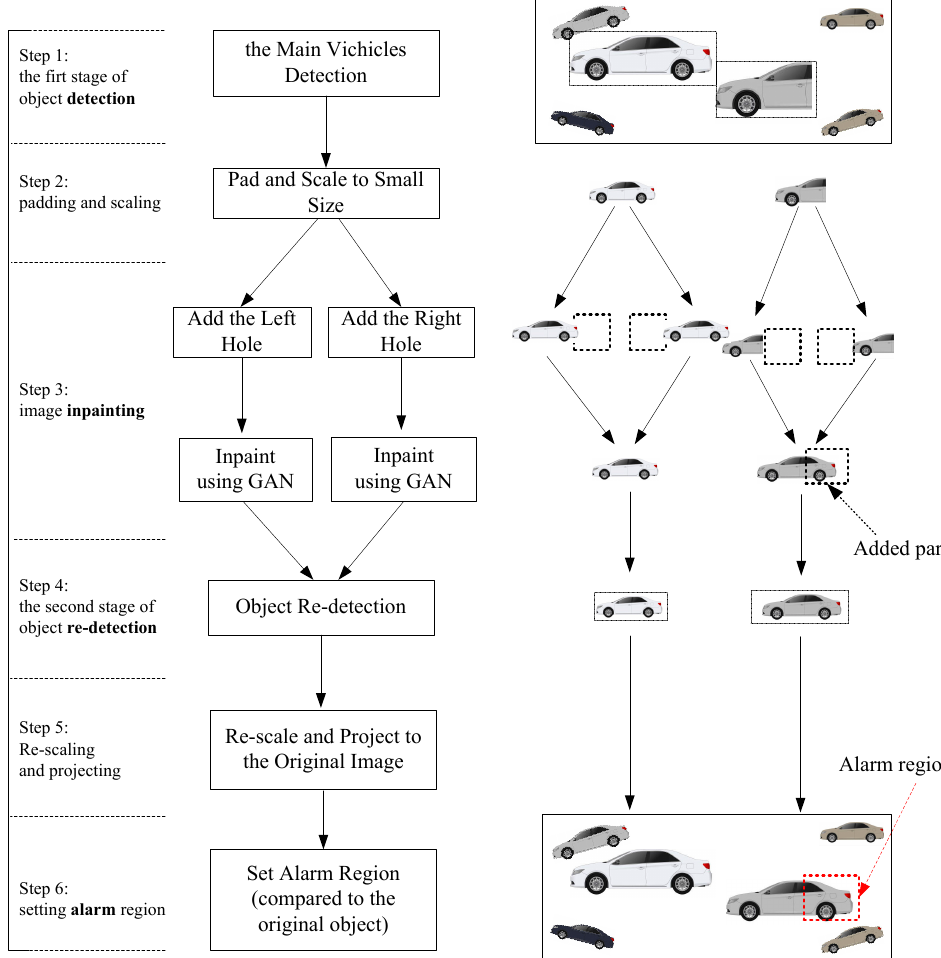
Figure 2. The flow chart demonstrates how to fill in a missing part.